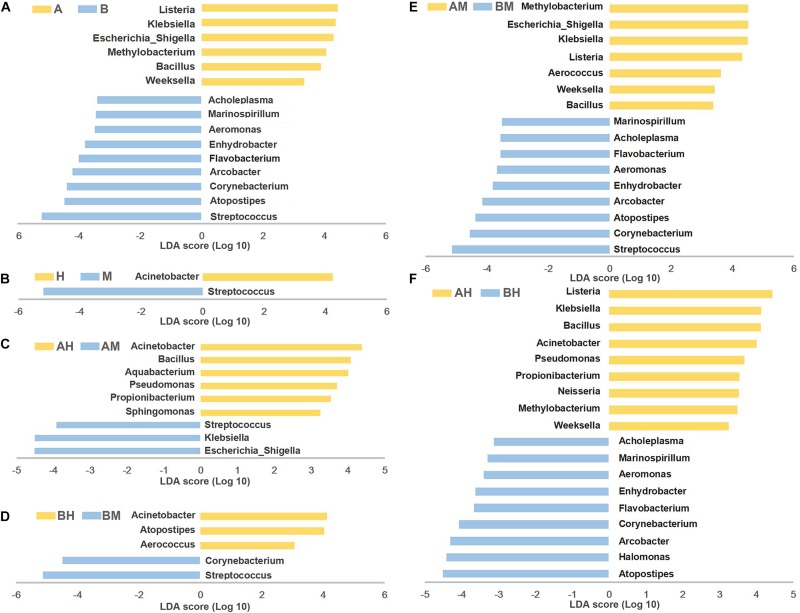
LEfSe analysis of microbiota. The microbial genera with significant differences in relative abundance compared between two groups are coded in blue and yellow as indicated in (A–F). Only the genera with an LDA score > 3 (P < 0.05) are depicted.